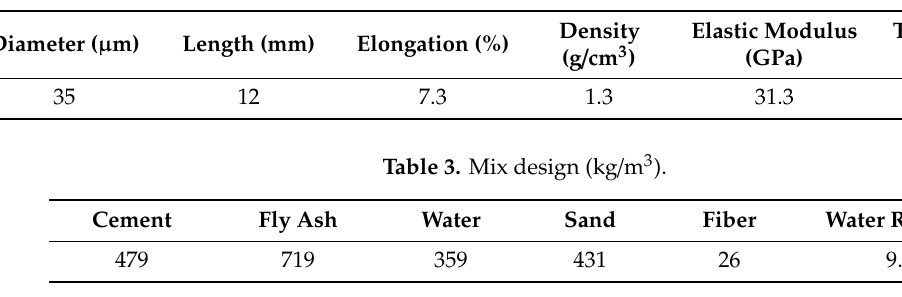
Table 2. Physical and mechanical properties of polyvinyl alcohol (PVA) fiber.